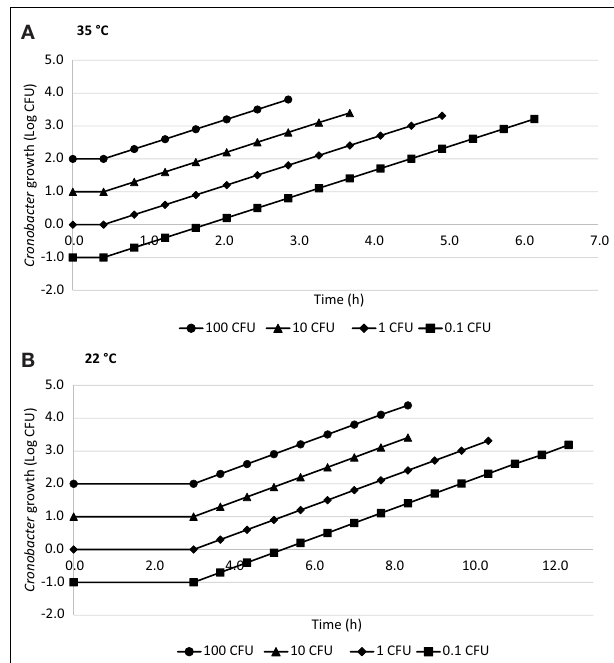
FIGURE 2 | Time to reach a hypothetical 1000CFU dose in R-PIF at 35°C (A) and 22°C (B) with 0.1, 1, 10, and 100CFU using ComBase generation time